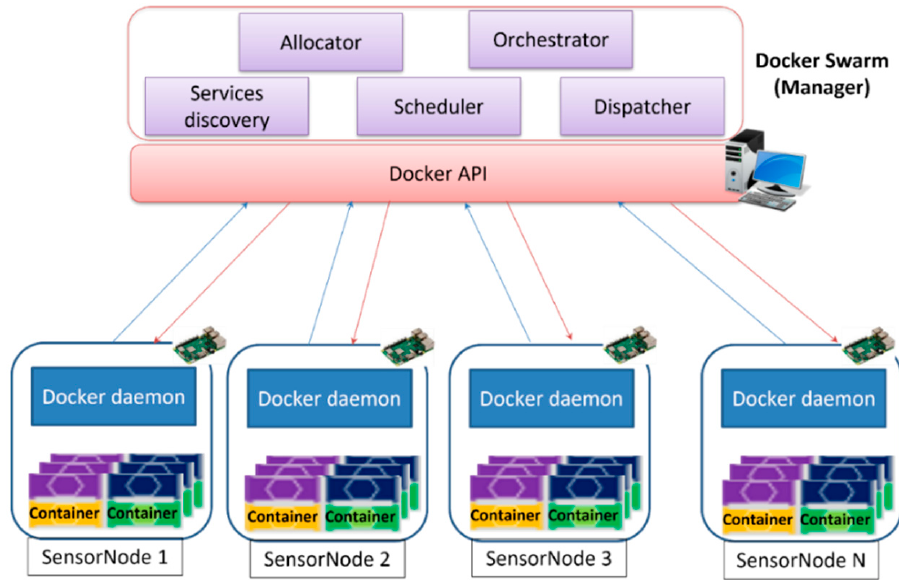
Figure 2. Architecture with containerization principles.